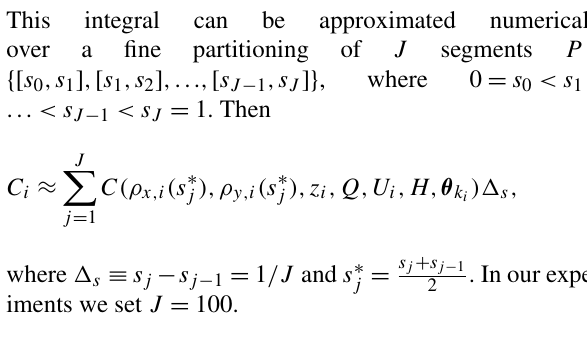
is scaled by i ,k i